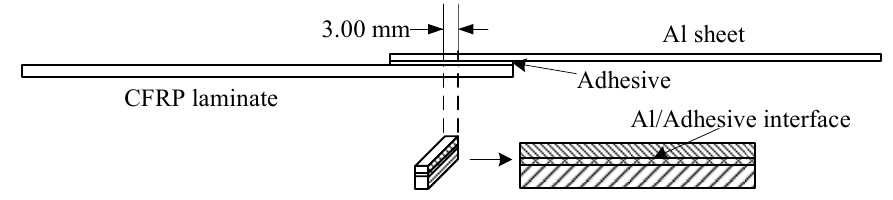
Figure 7. Sample for SEM and EDS test.